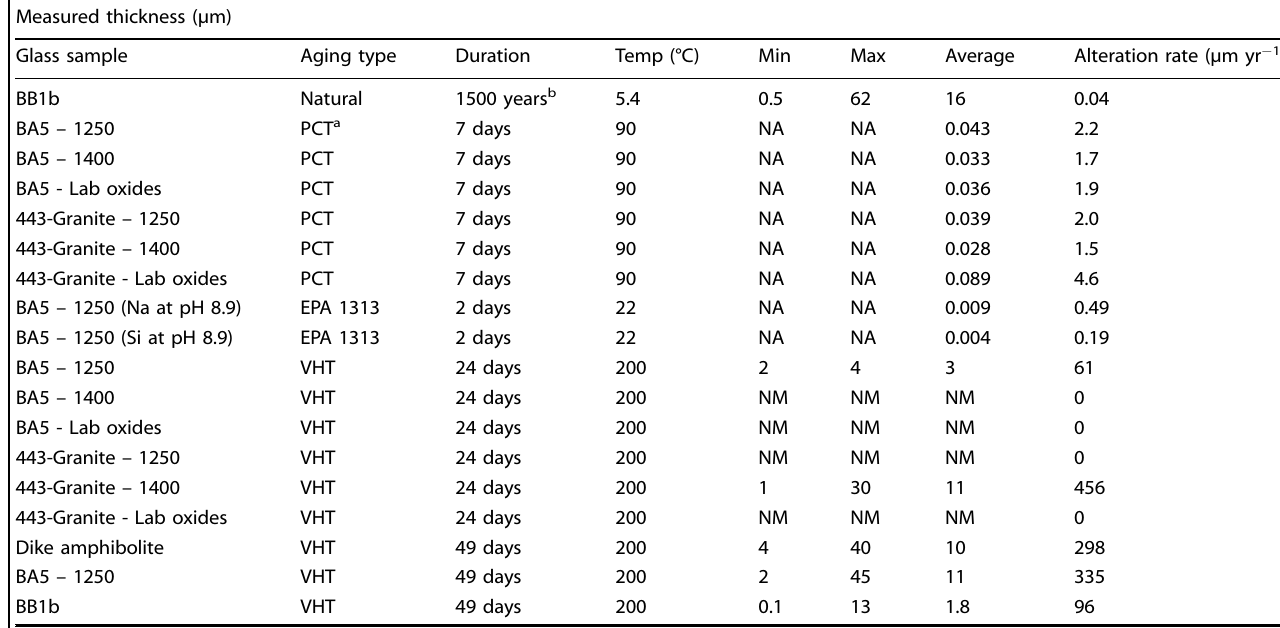
Table 4. Summary of aging types, durations, temperatures, sur fi cial layer thicknesses, and alteration rates for samples discussed here. Measured thickness (µm) Glass sample